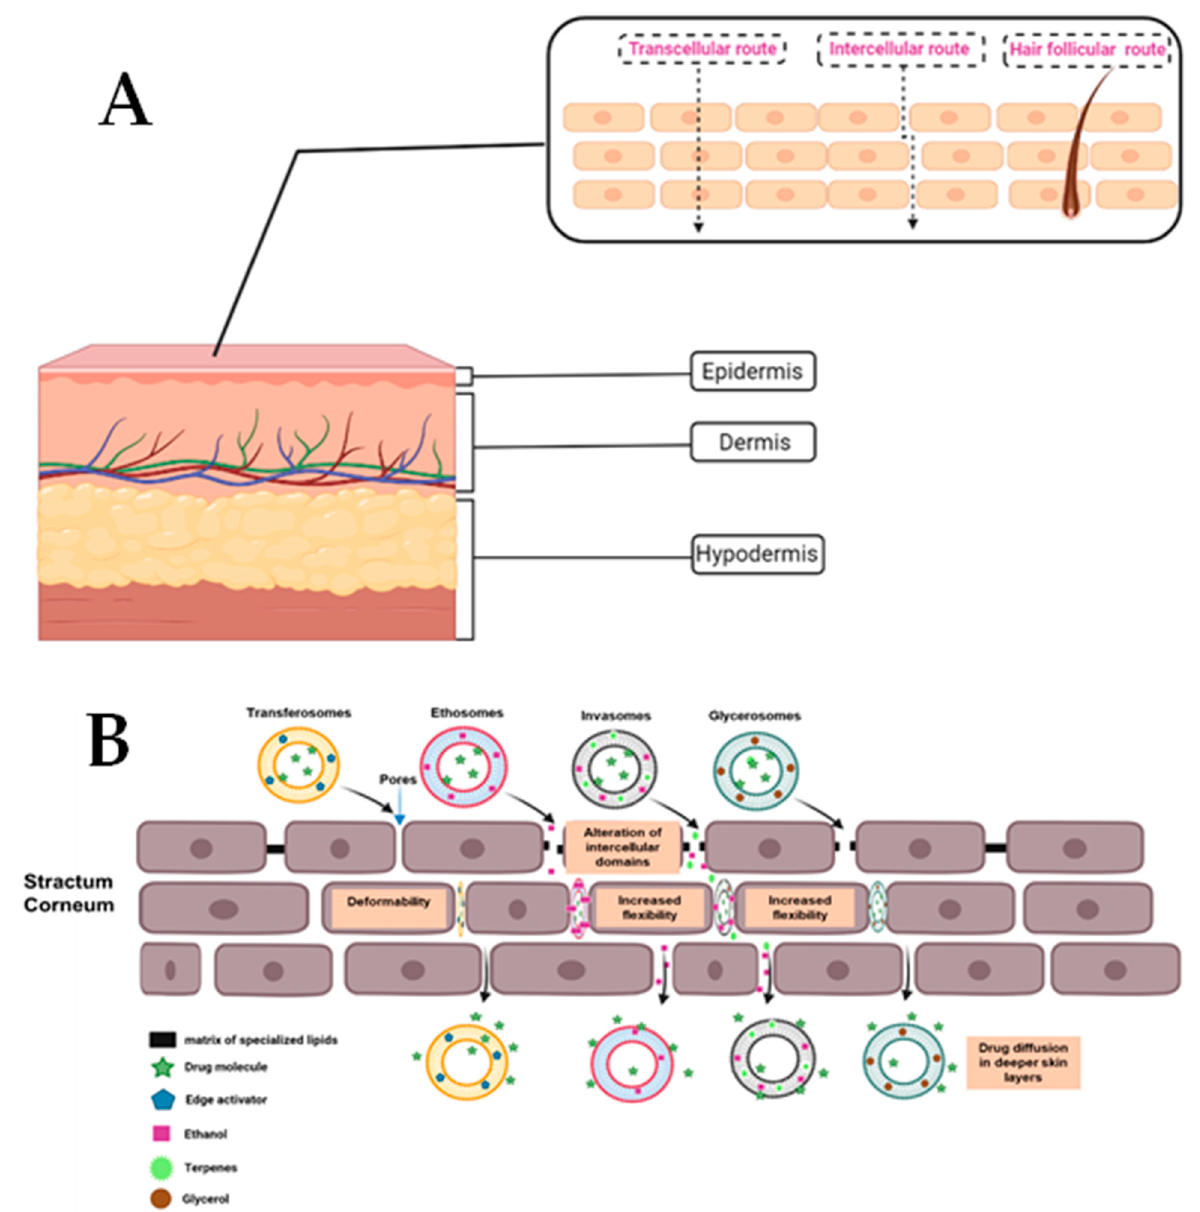
Figure 1. Graphic illustration of the structure of the skin and pathways for skin penetration of nanoparticles ( A ) and the mechanisms involved in advanced vesicular skin penetration ( B ). Adapted with permission from [54] and Elsevier B.V Netherlands.